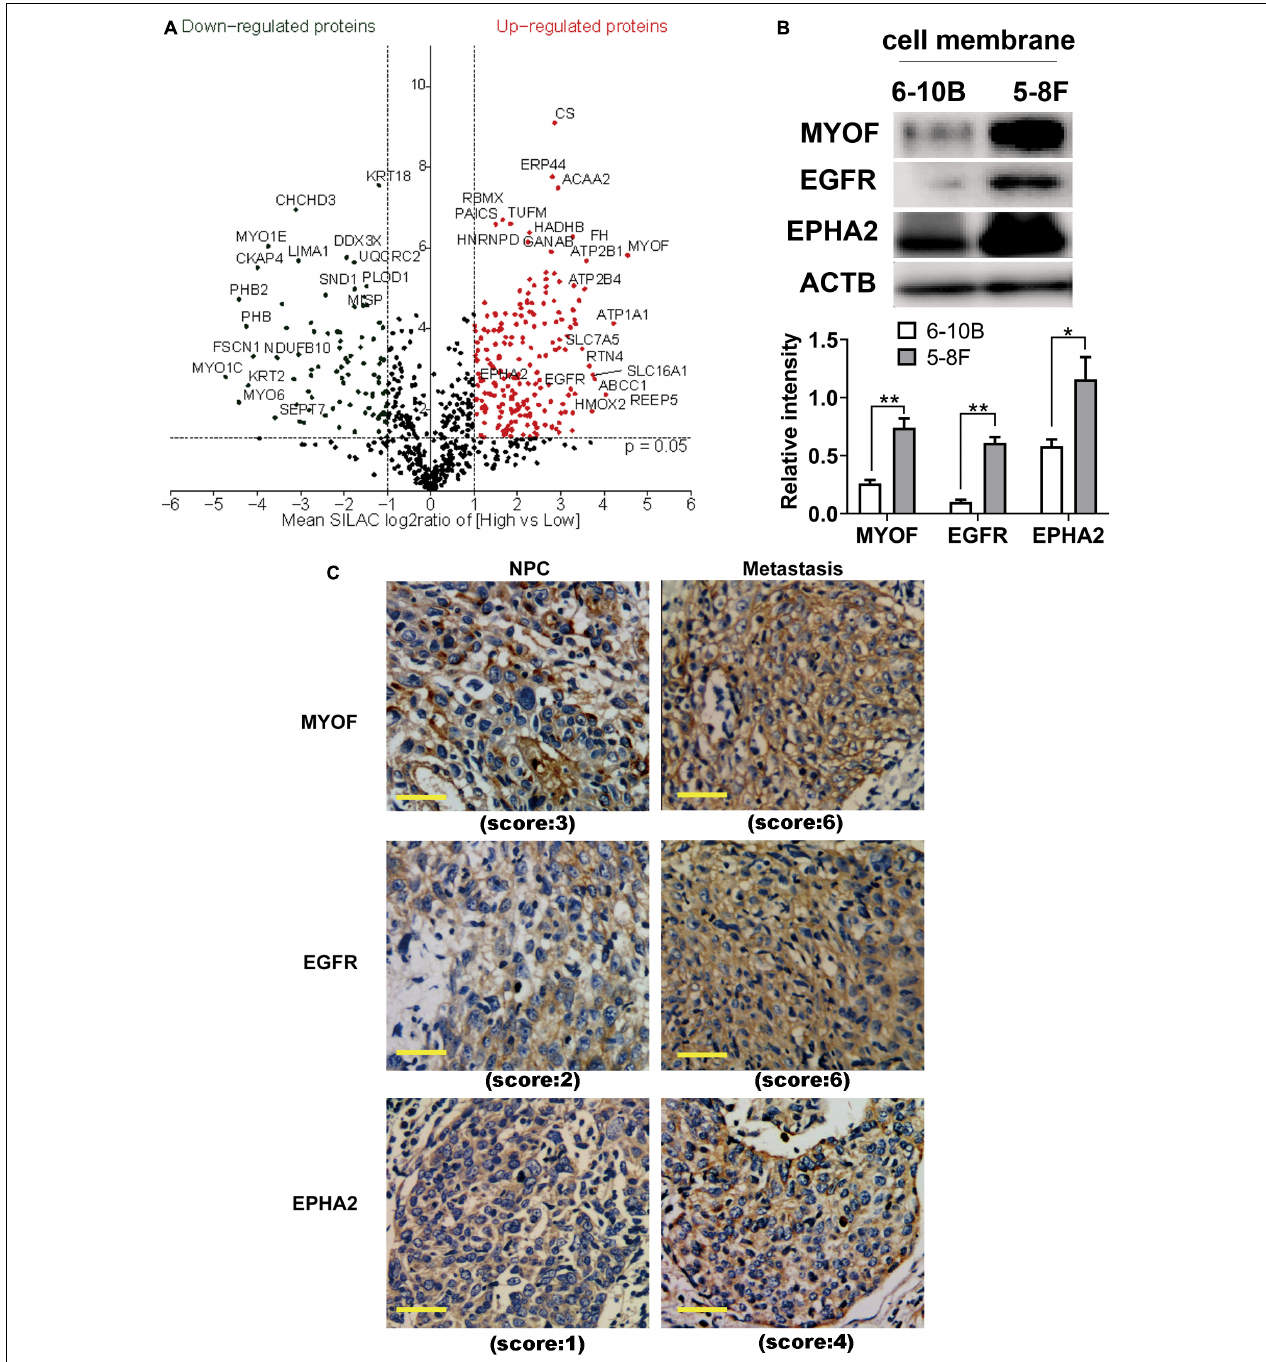
FIGURE 2 | Identification and evaluation of significantly altered proteins between the 6-10B and 5-8F cell lines. (A) Volcano plot indicating significantly altered surface-exposed proteins identified in the datasets. Log-transformed P -values ( t -test) against log-transformed fold change in abundance between 6-10B and 5-8F cells. (B) Western blot analysis evaluating the expression of proteins that reside in the plasma membrane. The density of the bands was analyzed by using NIH ImageJ software and normalized by the arbitrary units of b-actin. Data are the means ± SDs of 3 experiments. ** p < 0.05 and ** p < 0.01. (C) Representative immunohistochemistry (IHC) results showing increased detection of the indicated proteins in NPC with metastasis compared with NPC without